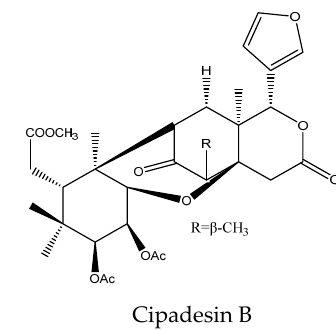
Figure 15. The structures of phragmalins.